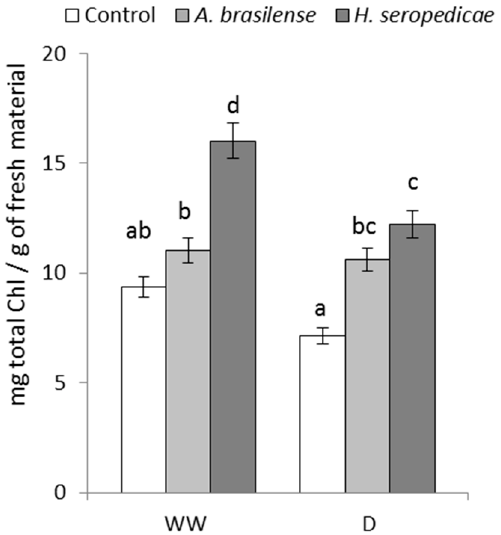
Figure 4. Total chlorophyll content 20 DAS. Data are shown as means ± SD ( n = 3). Means with common letters are not significantly different ( p > 0.05). The plants were cultivated under WW or D conditions. The inoculation * drought interaction p = 0.0273.